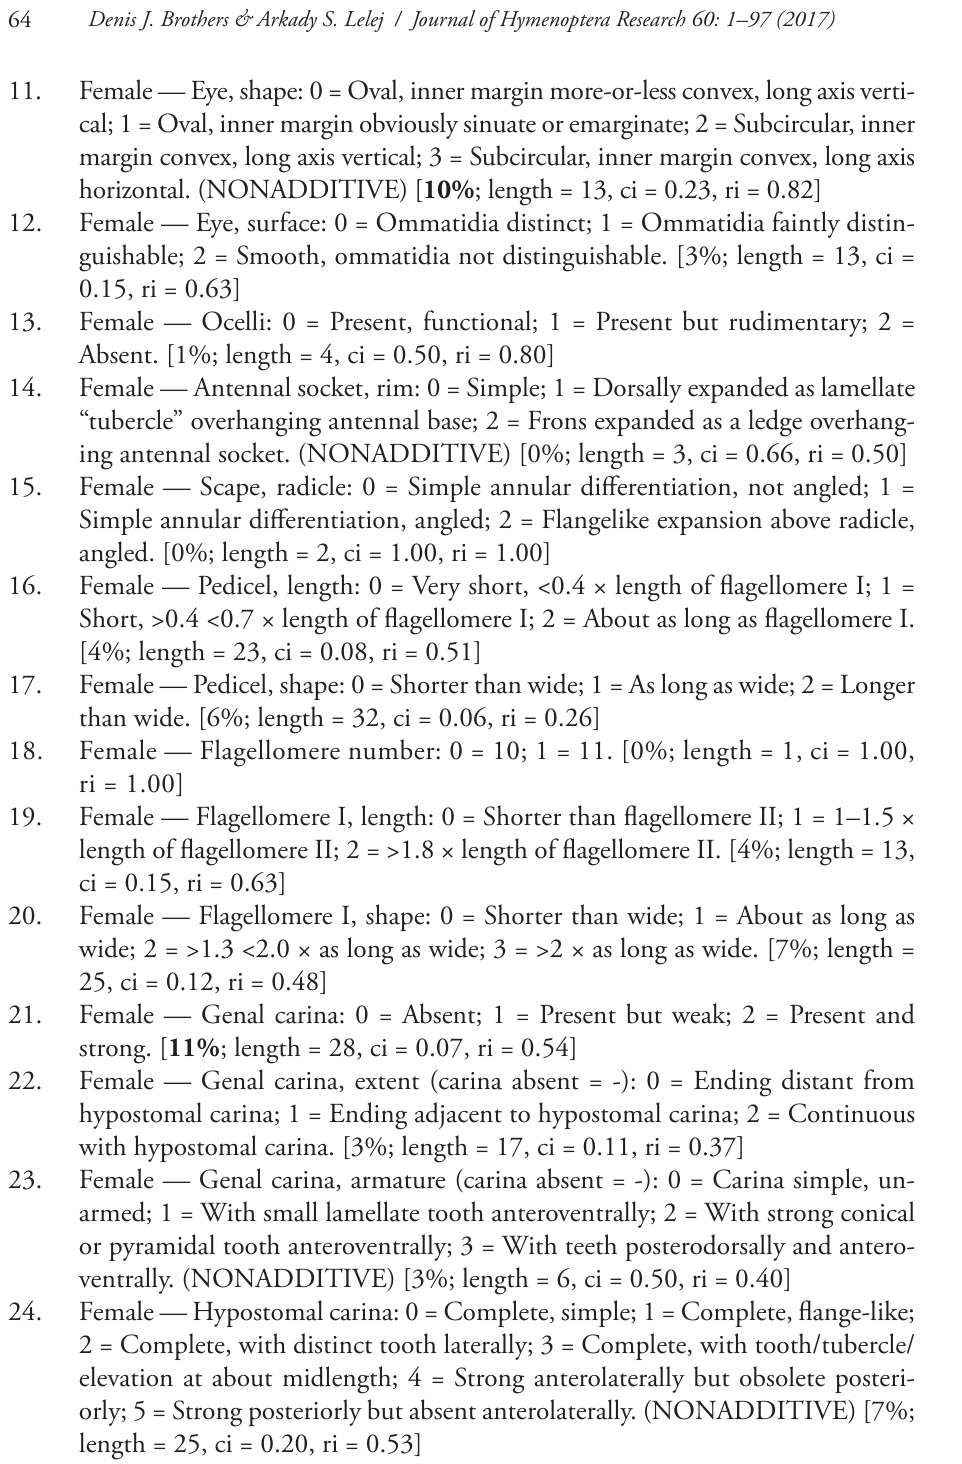
Female — Eye, shape: 0 = Oval, inner margin more-or-less convex, long axis verti- cal; 1 = Oval, inner margin obviously sinuate or emarginate; 2 = Subcircular, inner margin convex, long axis vertical; 3 = Subcircular, inner margin convex, long axis horizontal. (NONADDITIVE) [ 10% ; length = 13, ci = 0.23, ri =